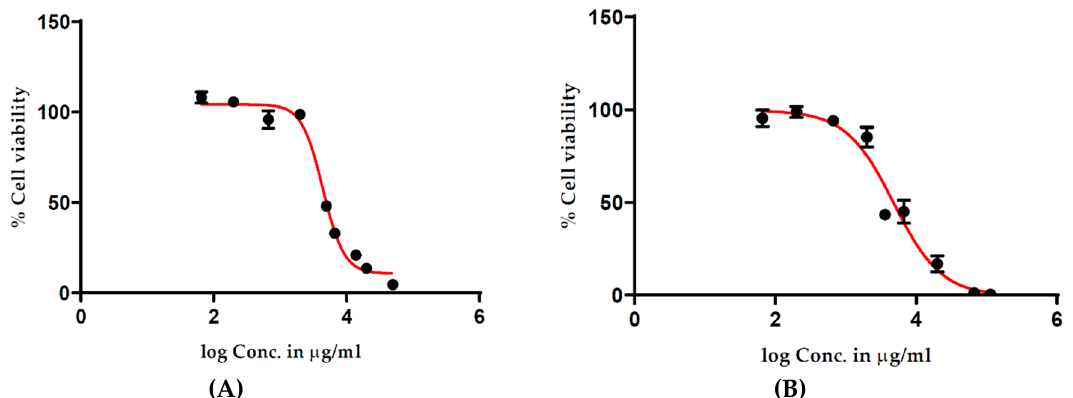
Figure 3. Effect of T. ferdinandiana methanolic ( A ) and water ( B ) extracts of fruits on HT29-MTX-E12 cell viability measured using the CyQUANT ® NF Assay. All concentrations were tested in triplicate with mean values ± SEM used to construct dose–response curves.